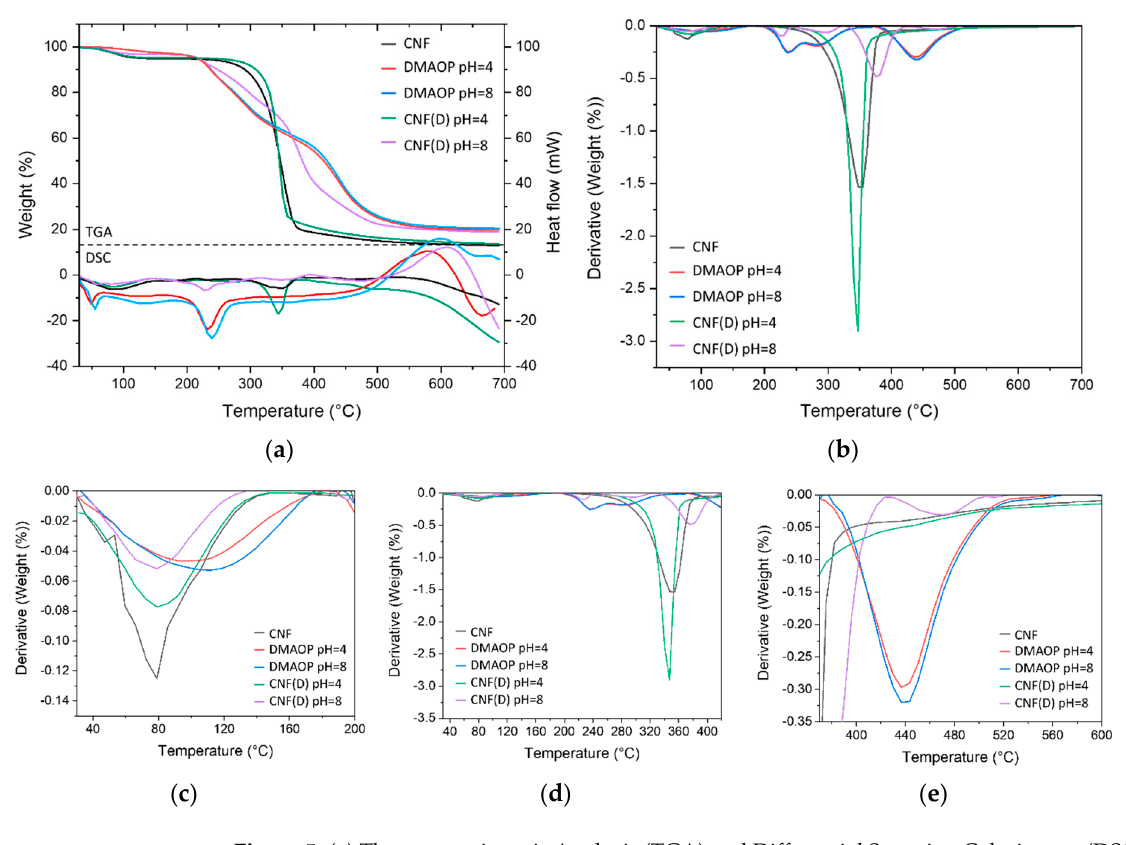
Figure 5. ( a ) Thermogravimetric Analysis (TGA) and Differential Scanning Calorimetry (DSC) curves, ( b ) derivation of the TGA curve with approximate areas ( c – e ), for samples of the reference CNF, the hydrolyzed reagent DMAOP at pH = 4 and pH = 8, and the product CNF(D) at pH = 4 and pH = 8. Table 2. Temperature areas and percentages of mass loss obtained by TGA analysis for samples of the reference CNF, the hydrolyzed reagent DMAOP at pH = 4 and pH = 8, and the product CNF(D) at pH = 4 and pH = 8.